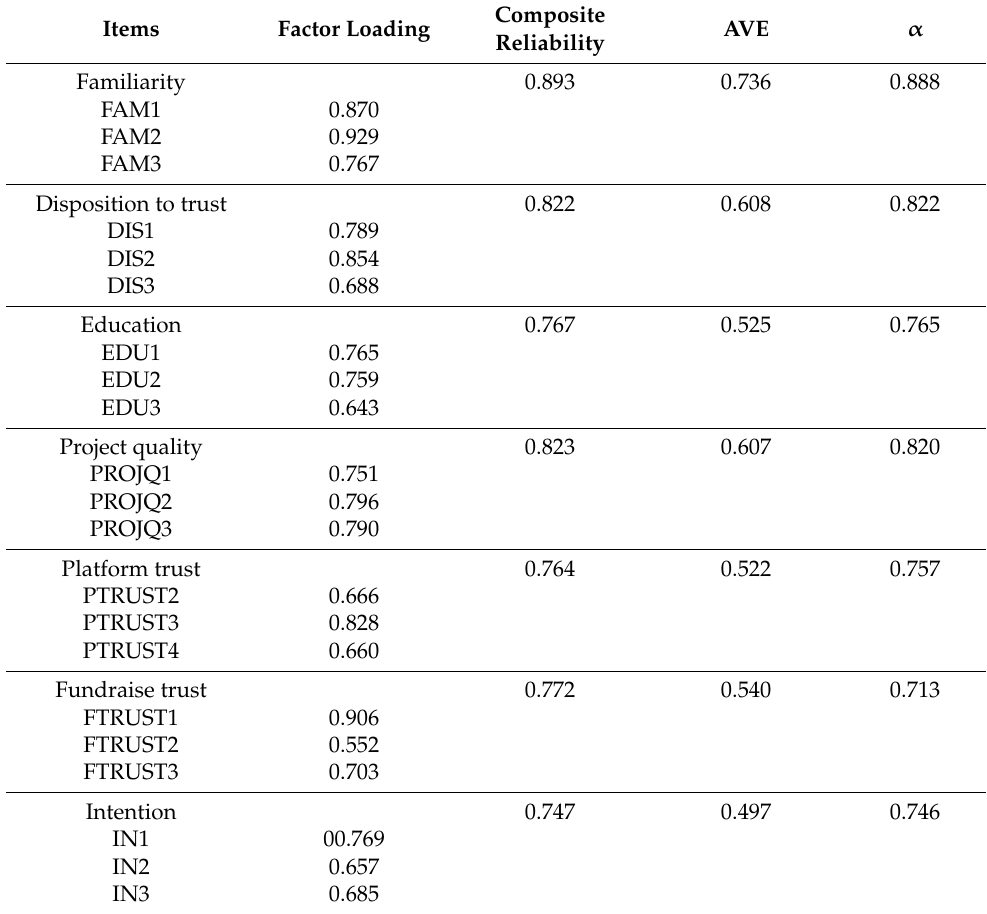
Table 3. Convergent validity indices and reliability